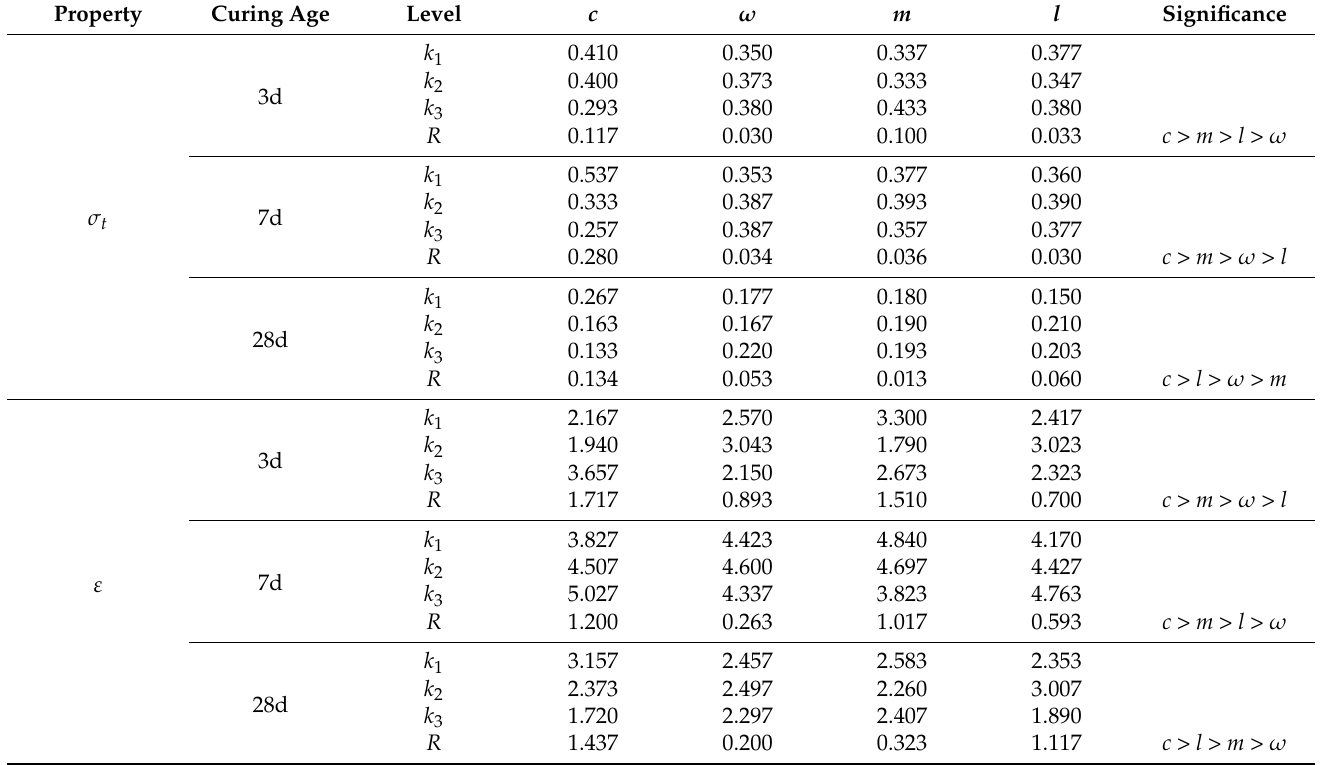
Table 6. Orthogonal range analysis